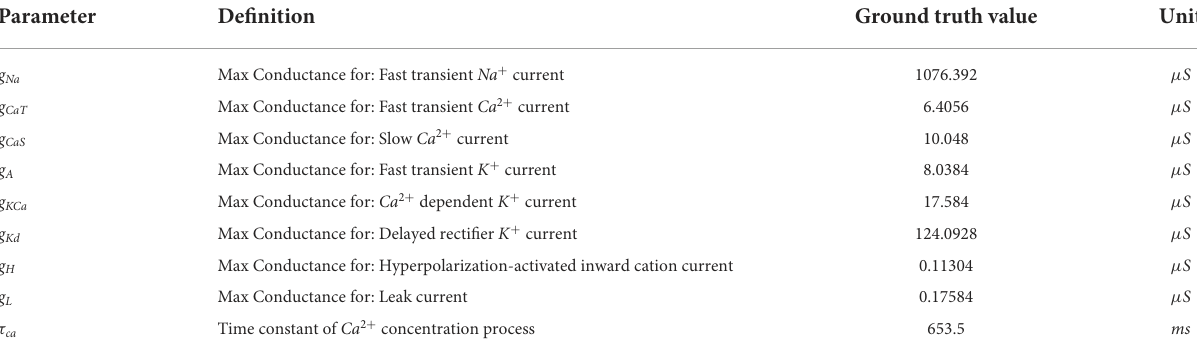
TABLE 1 Definition, values, and unit of the parameters that we seek to infer. Details for these definitions can be found in Alonso and Marder (2019) and Liu et al.